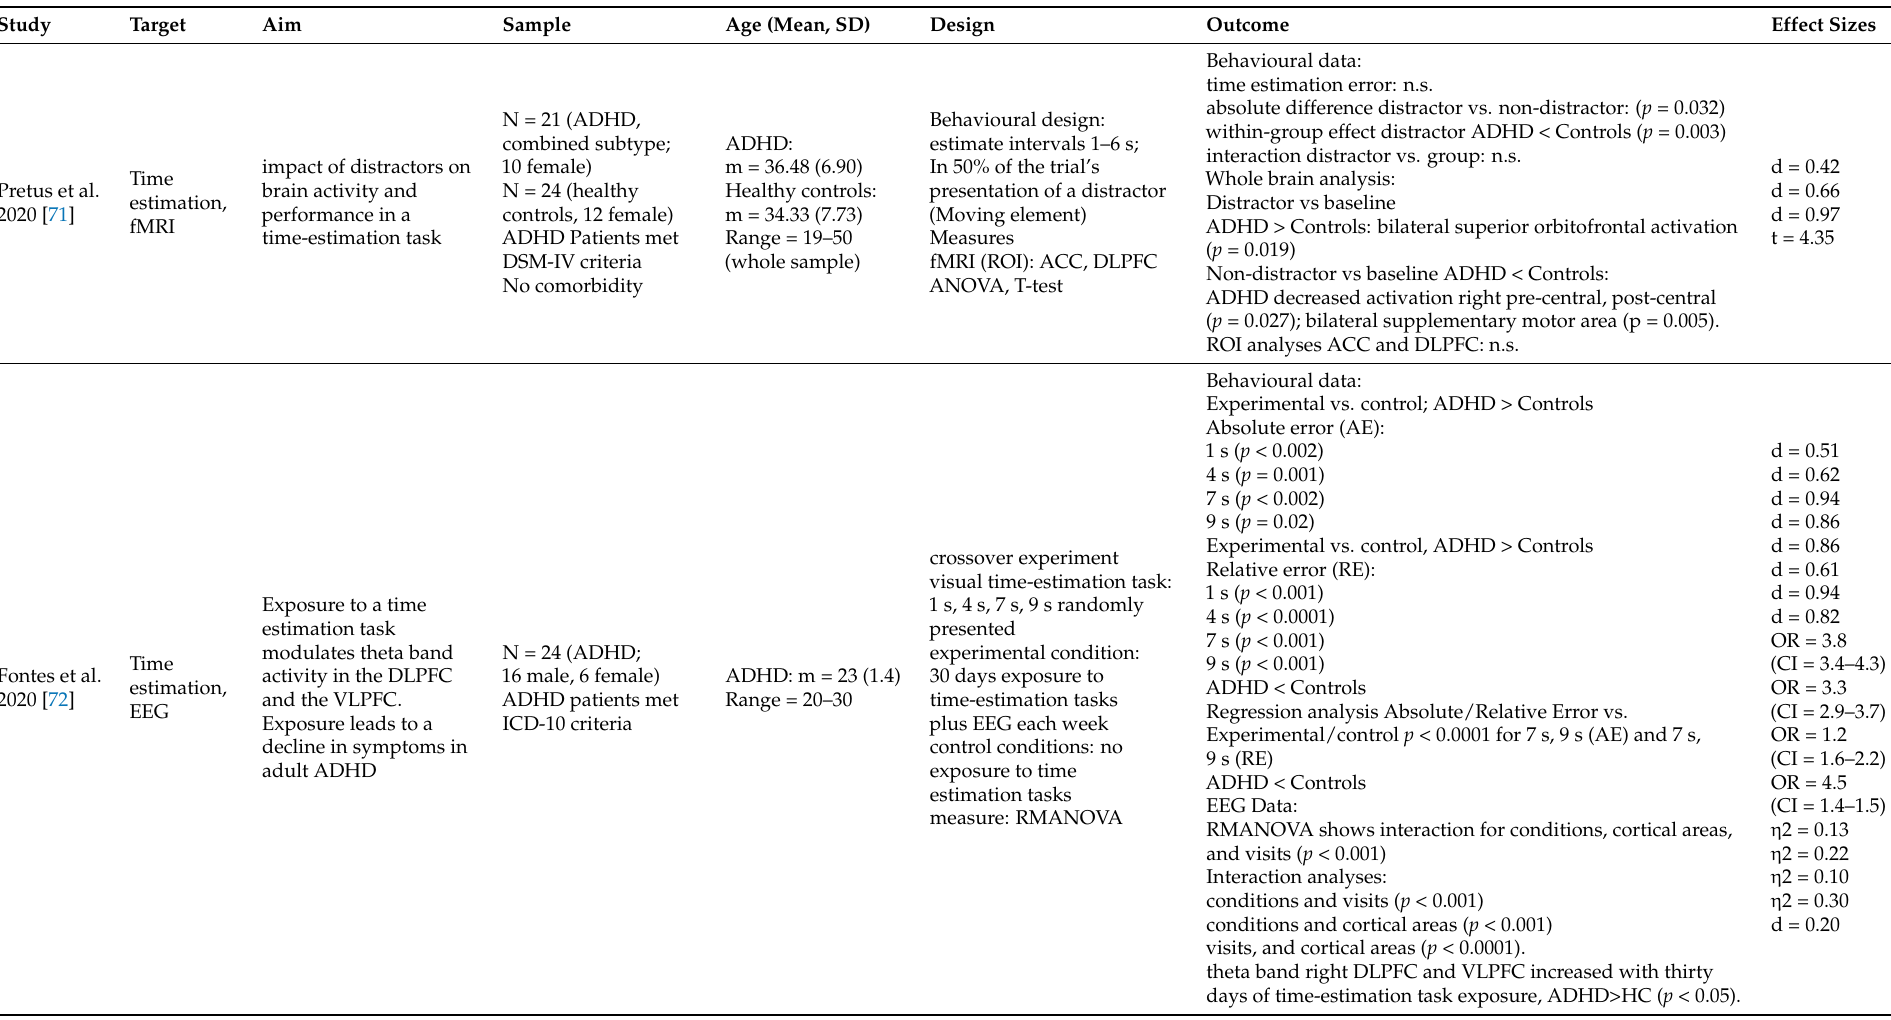
Table 1. Sample characteristics and results of reviewed studies (n =